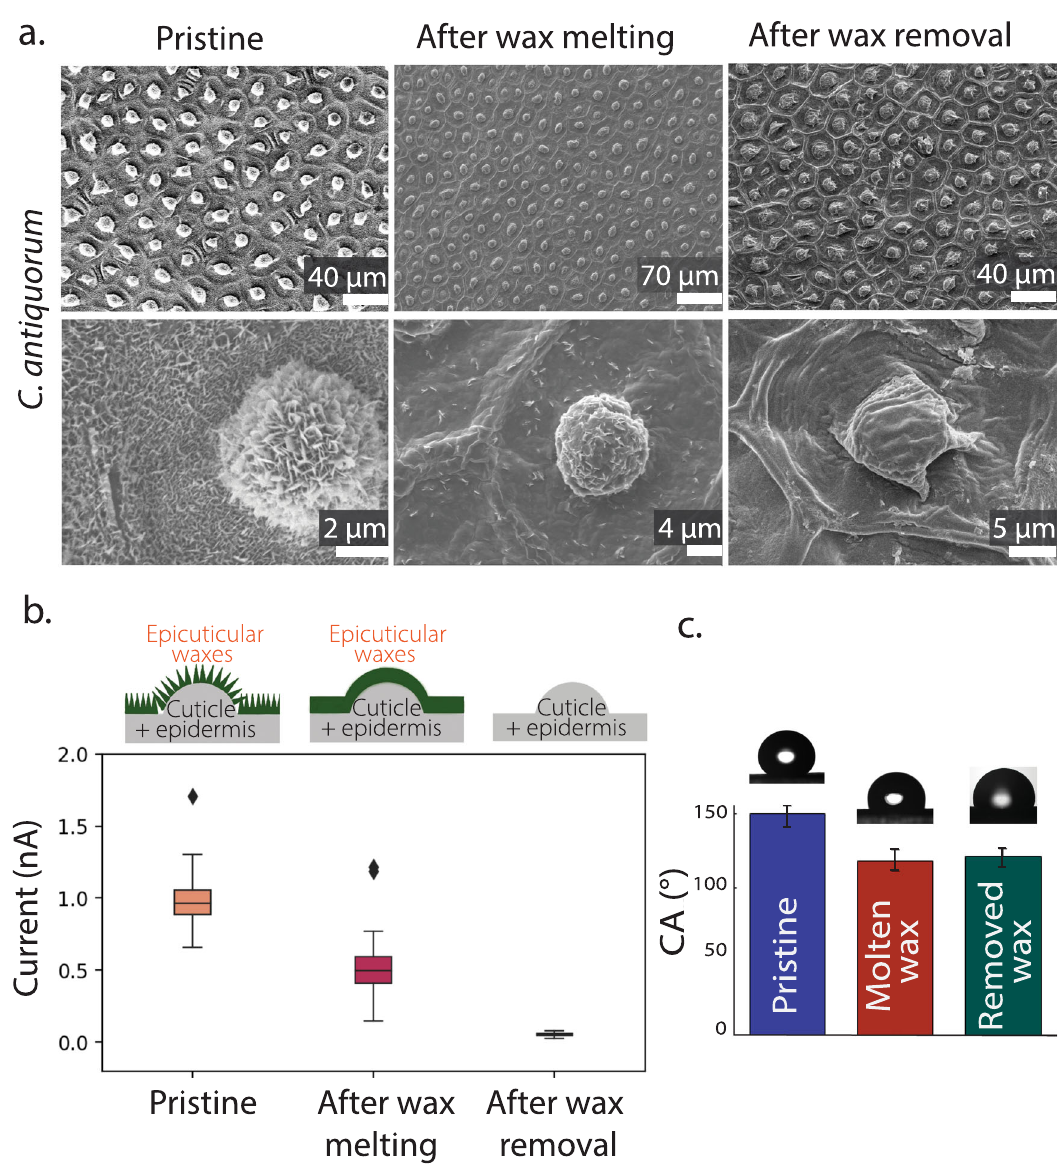
Fig. 6 In fl uence of nanostructure and selective removal of epicuticular waxes on the water-droplet contact electri fi cation of C. antiquorum . a Scanning electron microscope (SEM) of a C. antiquorum leaf when pristine, when epicuticular waxes are gently melted and when the waxes are removed. b Comparison of electric signals on a C. antiquorum leaf with intact waxes, molten wax, and removed waxes, respectively. The statistics refer to 50 droplets for the pristine and molten leaf, while for the wax removal case they refer to 20 droplets. Single-droplet signals for current, charge, and voltage are given in Supplementary Fig. 12. The schematics on top of the graph illustrate the different morphology of the waxes in the three cases reported: intact wax crystals in the pristine leaf, molten waxes forming a fl atter, continuous layer, and complete absence of epicuticular waxes. c Effect of the wax melting and wax removal on the water contact angle ( N = 5) of a C. antiquorum leaf. Standard deviation of fi ve measurements is